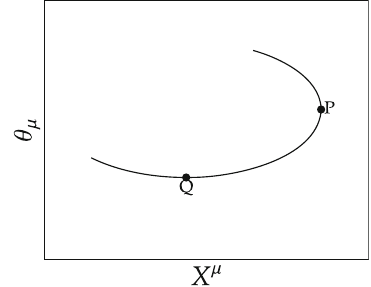
Fig. 2 Generic plot of a conjugate variable θ μ against X μ , along an equilibrium sequence. The point P is a turning point. The upper branch is unstable, while the lower branch can be either fully stable, or simply more stable than the upper branch. The sign of the slope also changes at the horizontal tangent at Q (cid:16) , but this has no relation with a change of stability, even if the slope changes sign